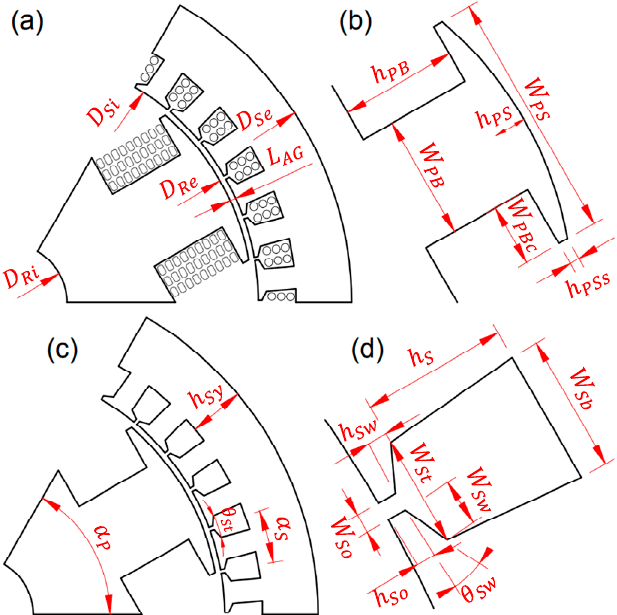
Figure 5. Main geometric parameters of the generator: ( a ) air-gap and diameters, ( b ) pole dimensions, ( c ) stator yoke and angles, and ( d ) slot dimensions.